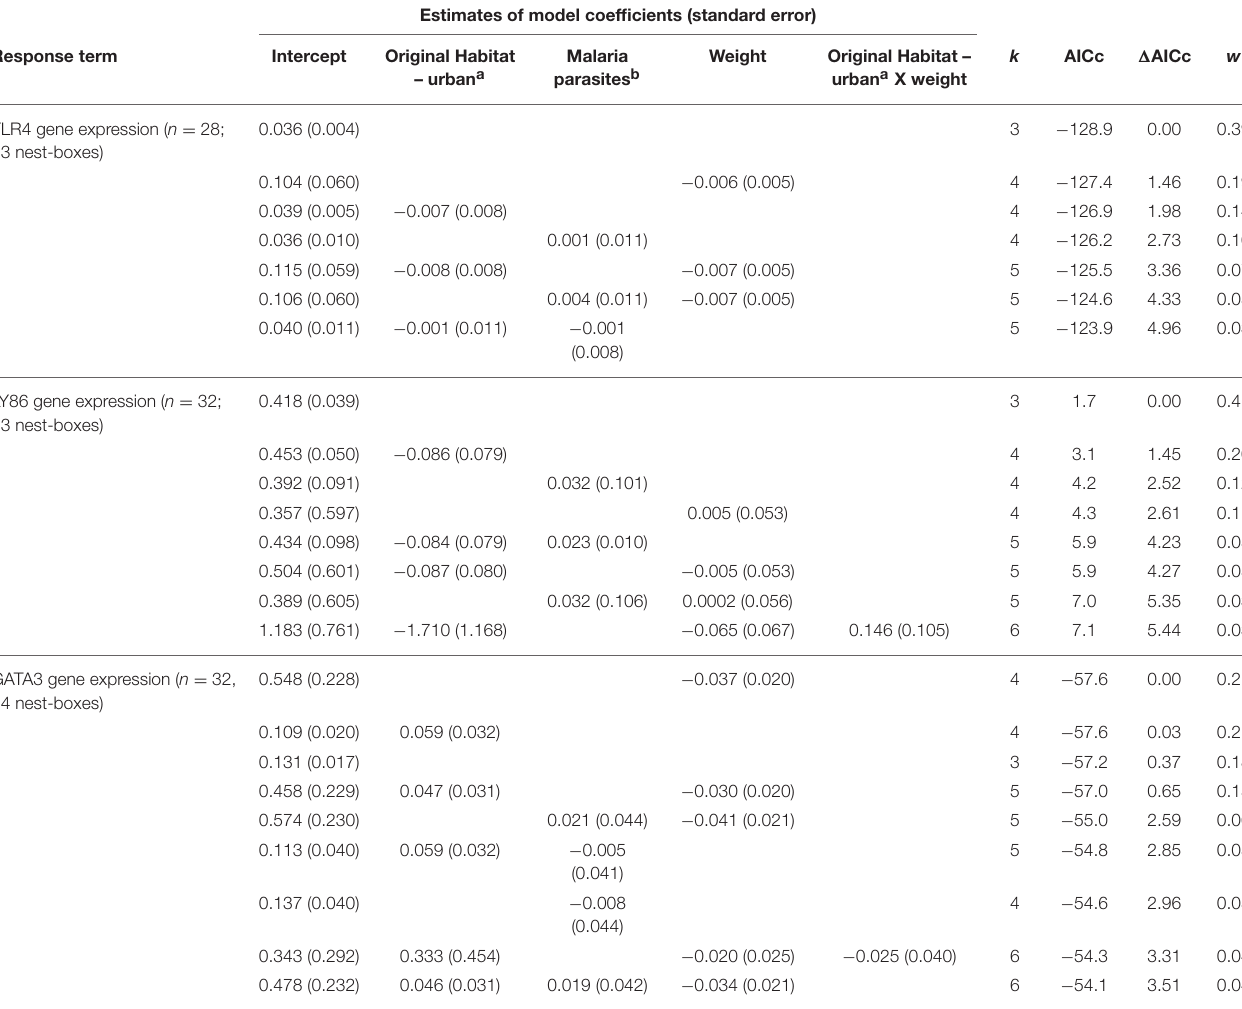
TABLE 3 | Summarizing table of statistical models employed to explain variation in TLR4, LY86, and GATA3 transcript levels for forest-reared nestlings. Estimates of model coefficients (standard error) Response